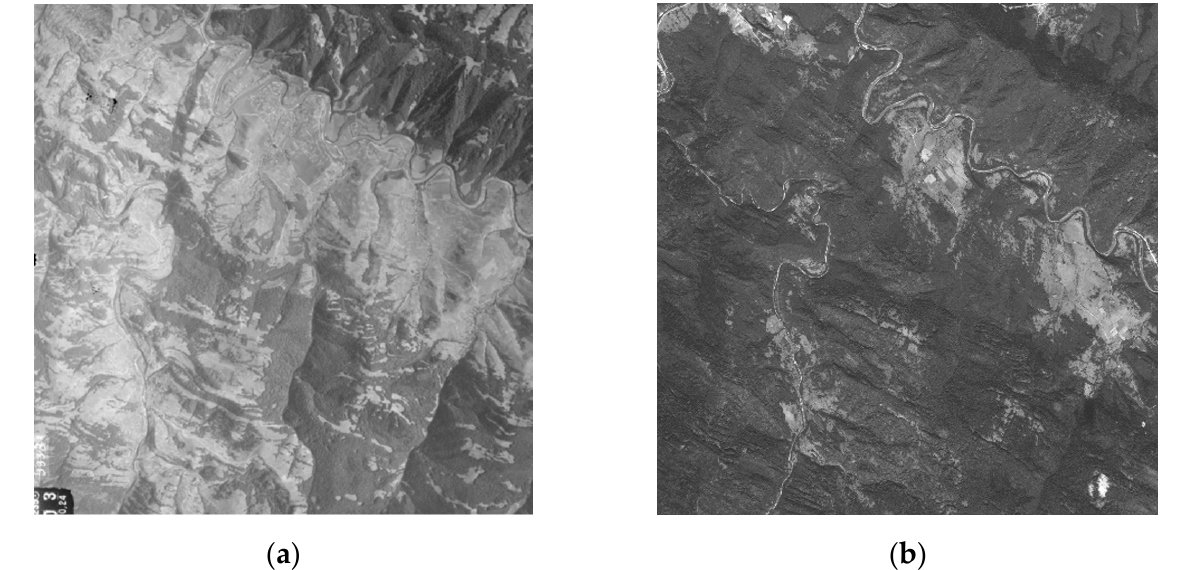
Figure 2. Example of the German Flown Aerial Photography taken in 1944 obtained from NARA U.S. ( a ) and a Corona Image from 1969 obtained from USGS ( b ).